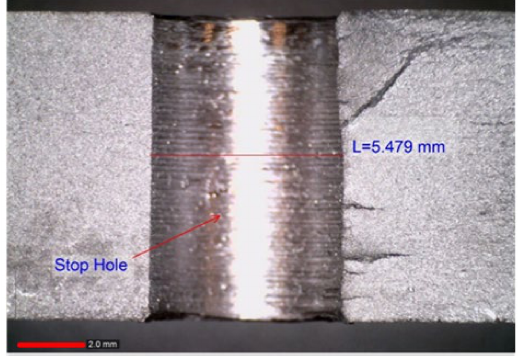
Figure 9. Specimen after stop hole technique testing procedure with re-initiated crack after the hole (crack growth direction from left to